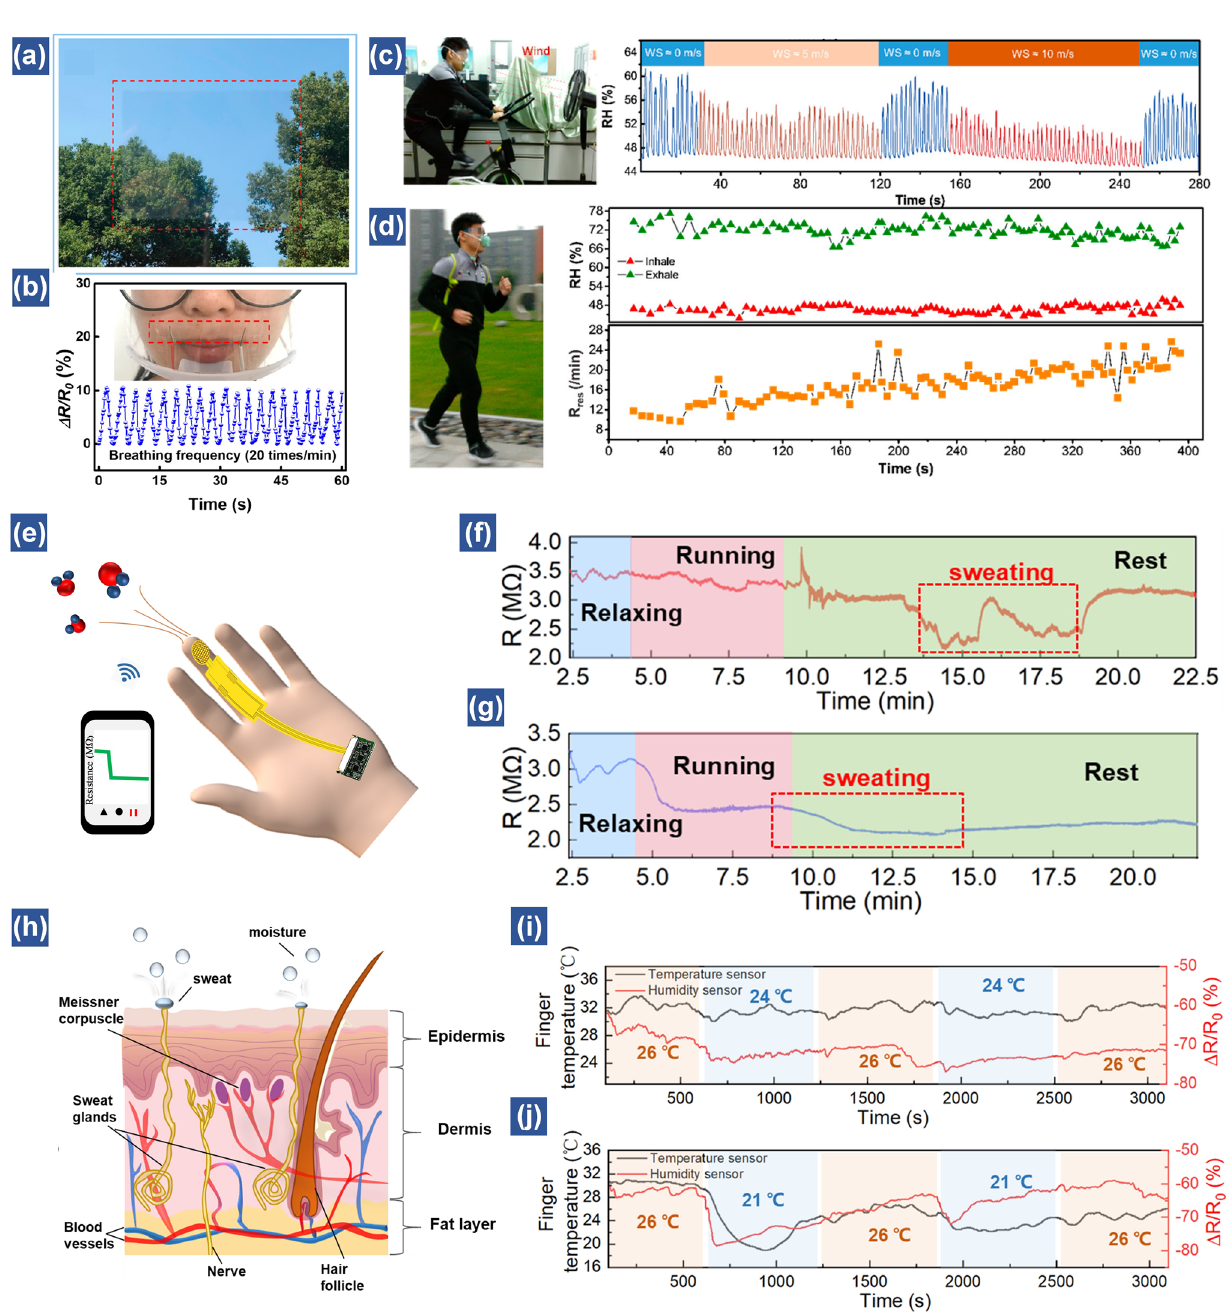
Fig. 9 Human healthcare monitoring based on humidity sensors. ( a ) Photograph of cellulose/KOH film. ( b ) Detection of the smooth breathing of an adult, with the inset being the photograph of the respiration test [51]. Copyright 2020 ACS Publications. ( c ) Illustrations of the subject to test the effect of wind speed (WS) to breath signal. ( d ) Real-time respiratory monitoring results of a volunteer during an outdoor jogging exercise (≈3 m s −1 ) [53]. Copyright 2018 ACS Publications. ( e ) Schematic of a wireless finger moisture application. Real-time finger moisture measurement of a subject conducted while running in a ( f ) dehydrated state and ( g ) well-hydrated state [46]. Copyright 2021 Royal Society of Chemistry. ( h ) Schematic picture of a finger-skin structure. Real-time monitoring results of the finger temperature and moisture variations of a volunteer who moved between a warm and a cold room with a temperature difference of ( i ) 2 °C and ( j ) 5 °C [52]. Copyright 2021